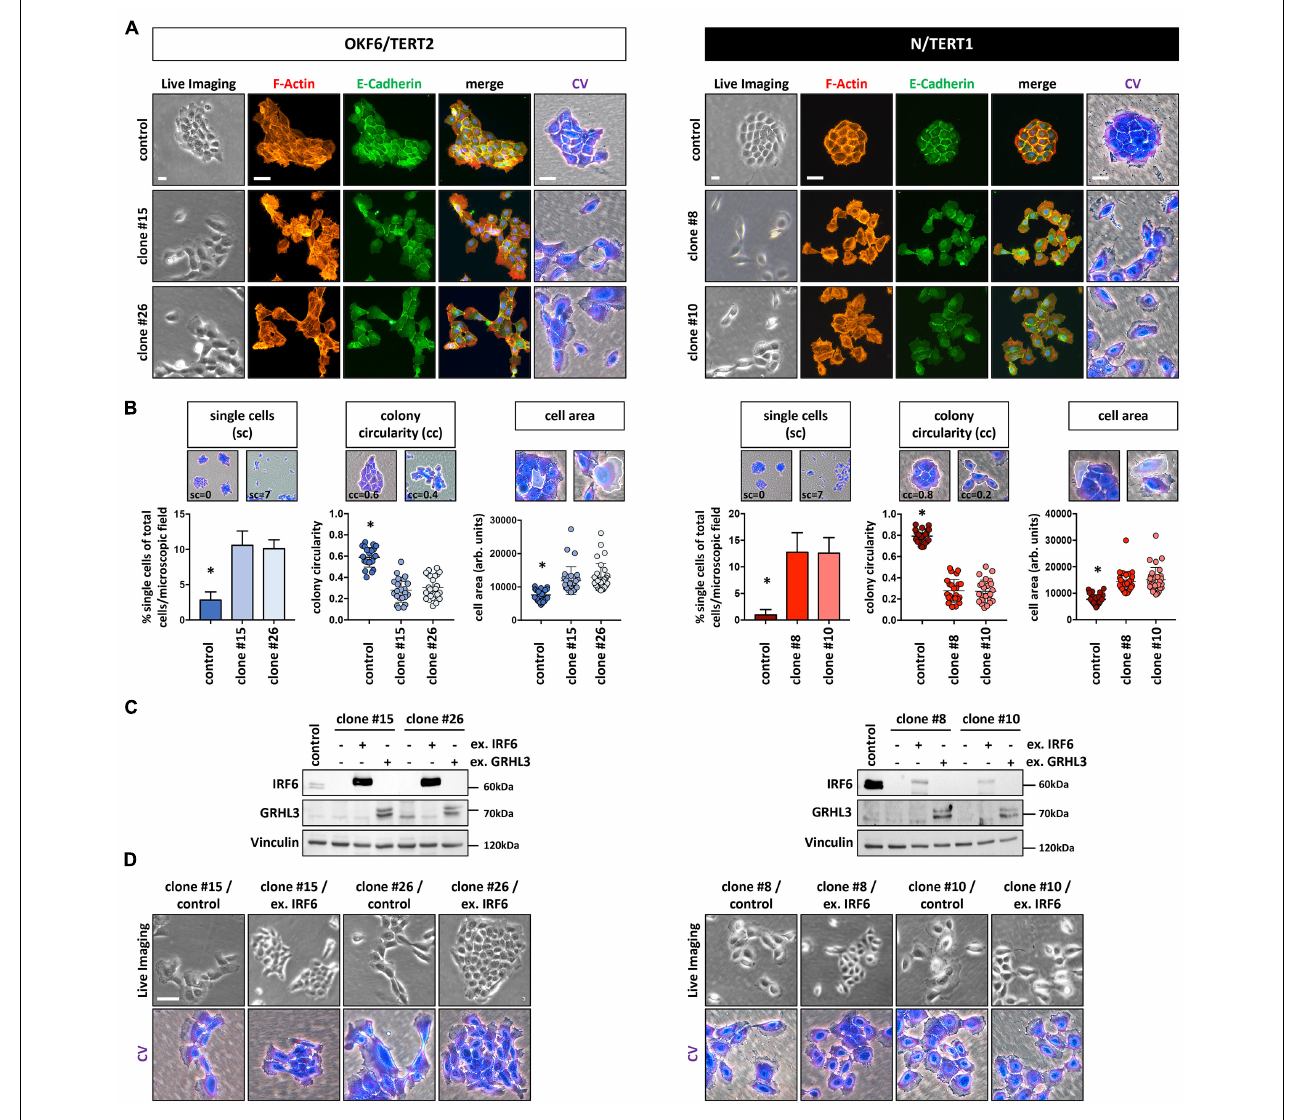
FIGURE 2 | (A) In the absence of IRF6, OKF6/TERT2 and N/TERT1 keratinocytes change their colony morphology as assessed by live imaging, F-actin (phalloidin, red), E-Cadherin (green), and crystal violet (CV) staining. DAPI was used to stain for nuclei (blue). Scale bars: 20 µ m (Live Imaging); 150 µ m (F-Actin, E-Cadherin); 100 µ m (CV). (B) IRF6 knockout in both OKF6/TERT2 and N/TERT1 cell lines results in significantly more single cells (sc), reduced colony circularity (cc) as well as in the emergence of larger single cells (cell area) when compared to their respective controls. ∗ p < 0.05 controls vs. clones (sc); ∗ p < 0.05 controls vs. clones (cc, cell area). (C) Immunoblots show overexpression of IRF6 and GRHL3 in the IRF6-deficient keratinocyte clones after transduction. Note the very little expression of ectopic IRF6 in N/TERT1 IRF6 knockout clones. kDa: kilo Dalton; ex.: exogenous. (D) Live imaging and crystal violet pictures of typical colony morphologies upon re-expression of IRF6 in the IRF6 K.O. clones. Note that low IRF6 levels are not able to rescue the dispersed colony phenotype. Scale bar: 100 µ m. Full-length immunoblots are shown in Supplementary Figure 9